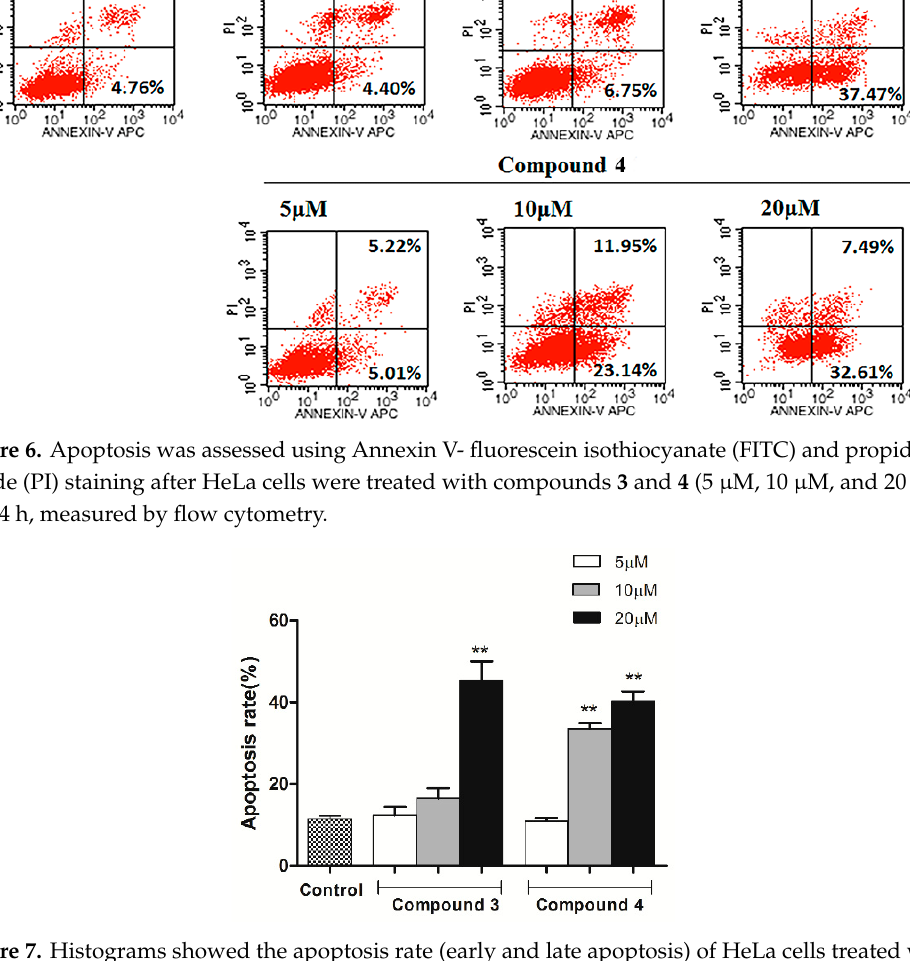
Figure 7. Histograms showed the apoptosis rate (early and late apoptosis) of HeLa cells treated with compounds 3 and 4 . The values are expressed as mean ± SD of triplicate experiments. ** p < 0.01 compared with the control group.